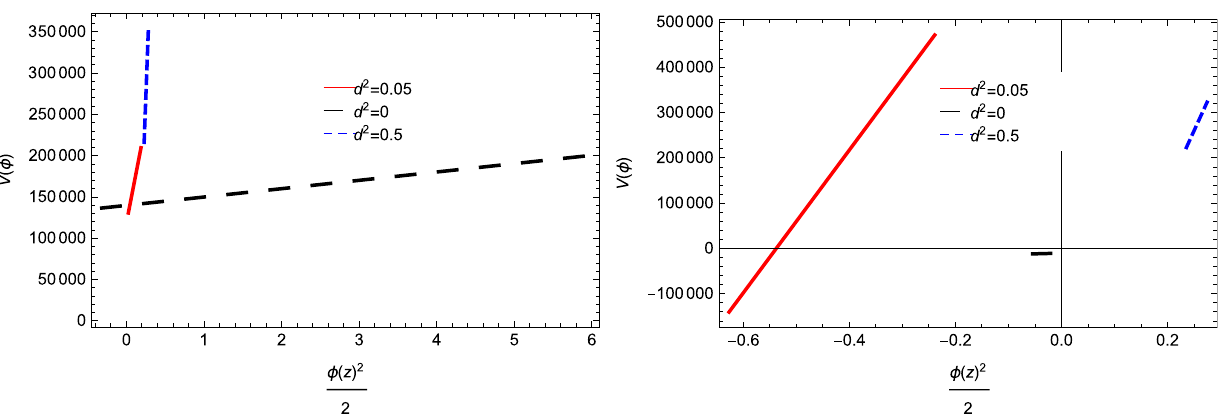
Fig. 12 Plot of V verses z for u = 1 and u = 2 . 002 for K-essence scalar field model